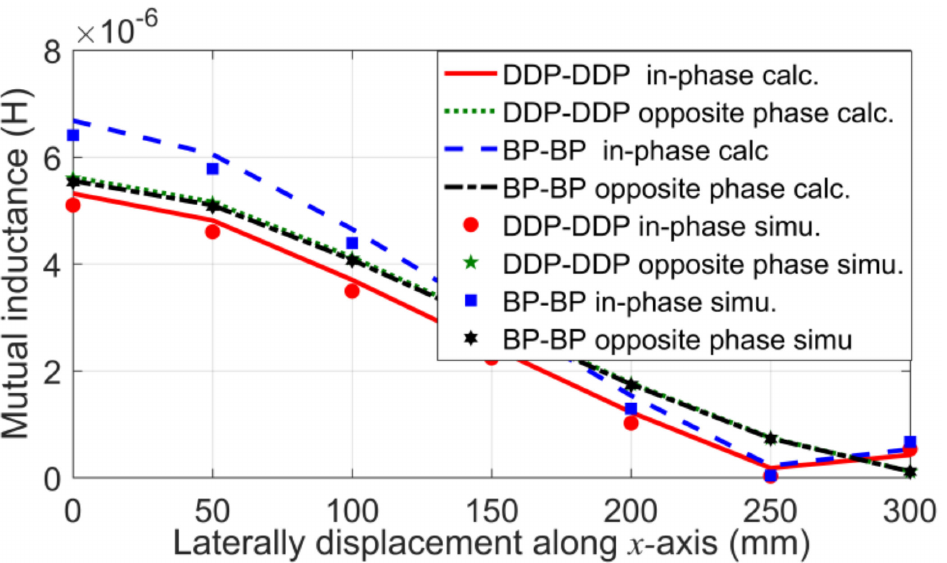
Figure 4. Mutual inductance of coils under misalignment along the x -axis and in different excitation